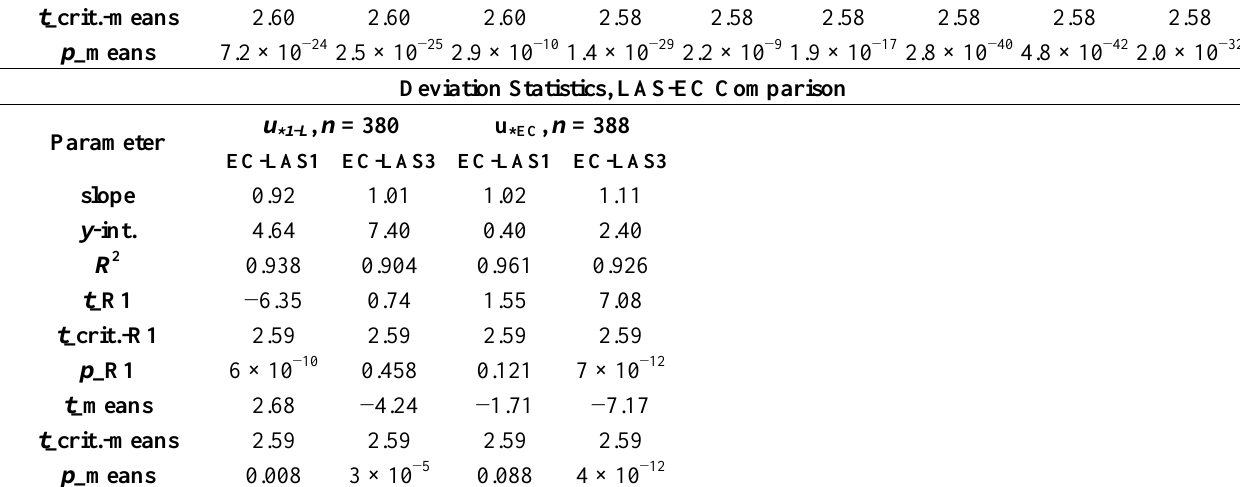
1 Bold red text represents potentially significant skewness and kurtosis as described in [34], suggesting departure from normal